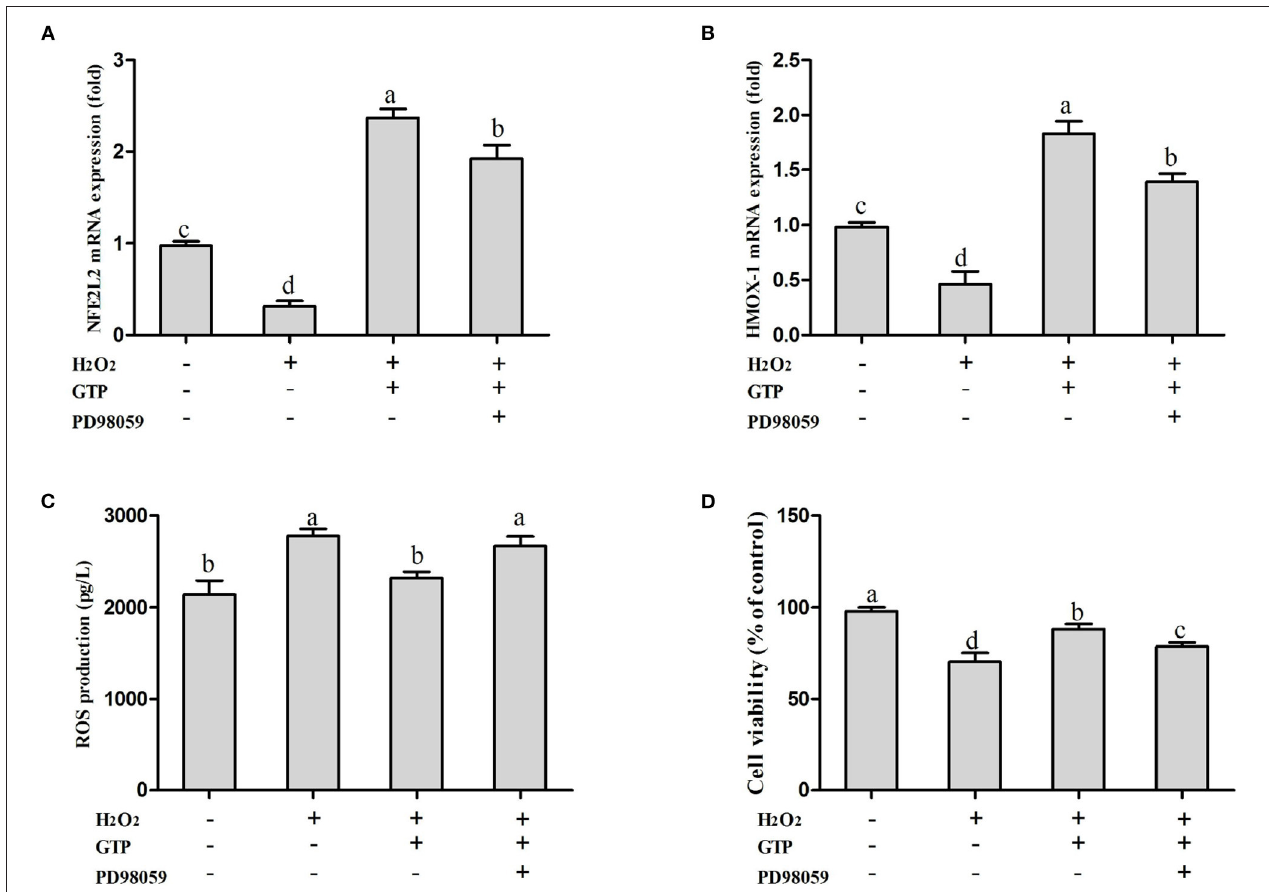
FIGURE 7 | Inhibition on MAPK affected the activation effects of GTP on the NFE2L2 signaling pathway and the cell protection effects of GTP. (A) NFE2L2 mRNA level, (B) HMOX1 mRNA level, (C) ROS level, and (D) cell viability of BMECs. a,b,c,d, the adjacent lowercase letters indicate significant difference, the alternate lowercase letters indicate extremely significant difference, and the same lowercase letters indicate insignificant